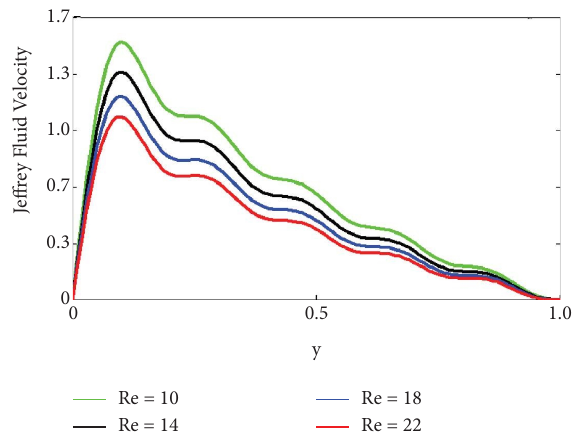
Figure 10: Te impact of diferent values of Re on ψ ( y,t )